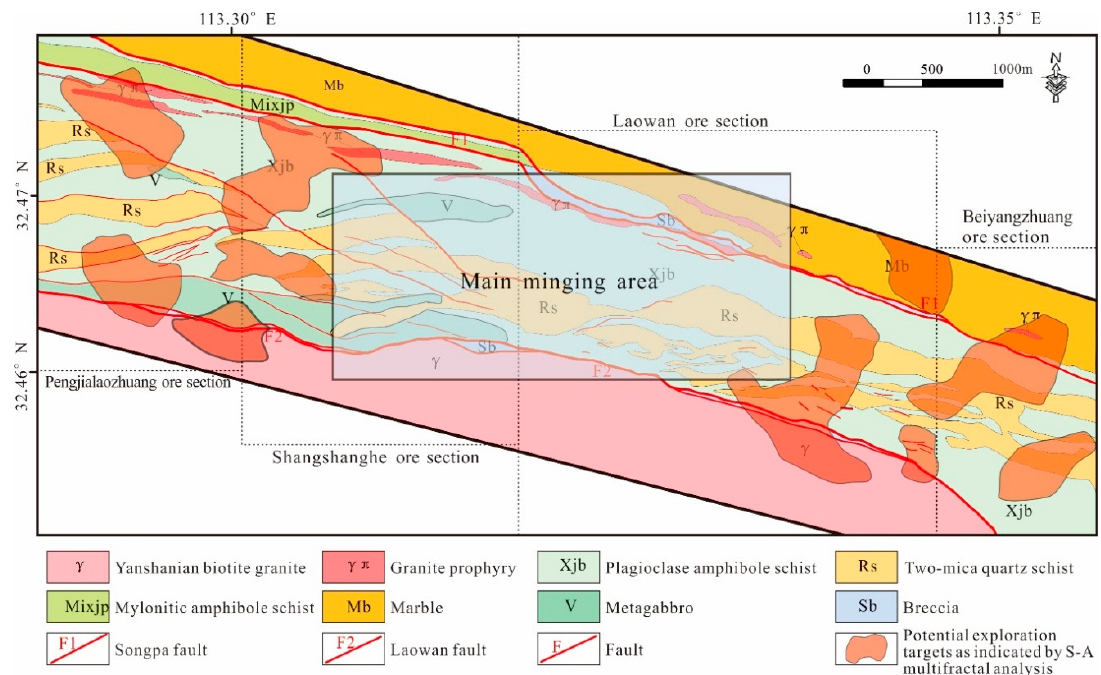
Figure 11. Predictive mapping of potential exploration targets, as indicated by the anomaly map of S–A multifractal analysis.